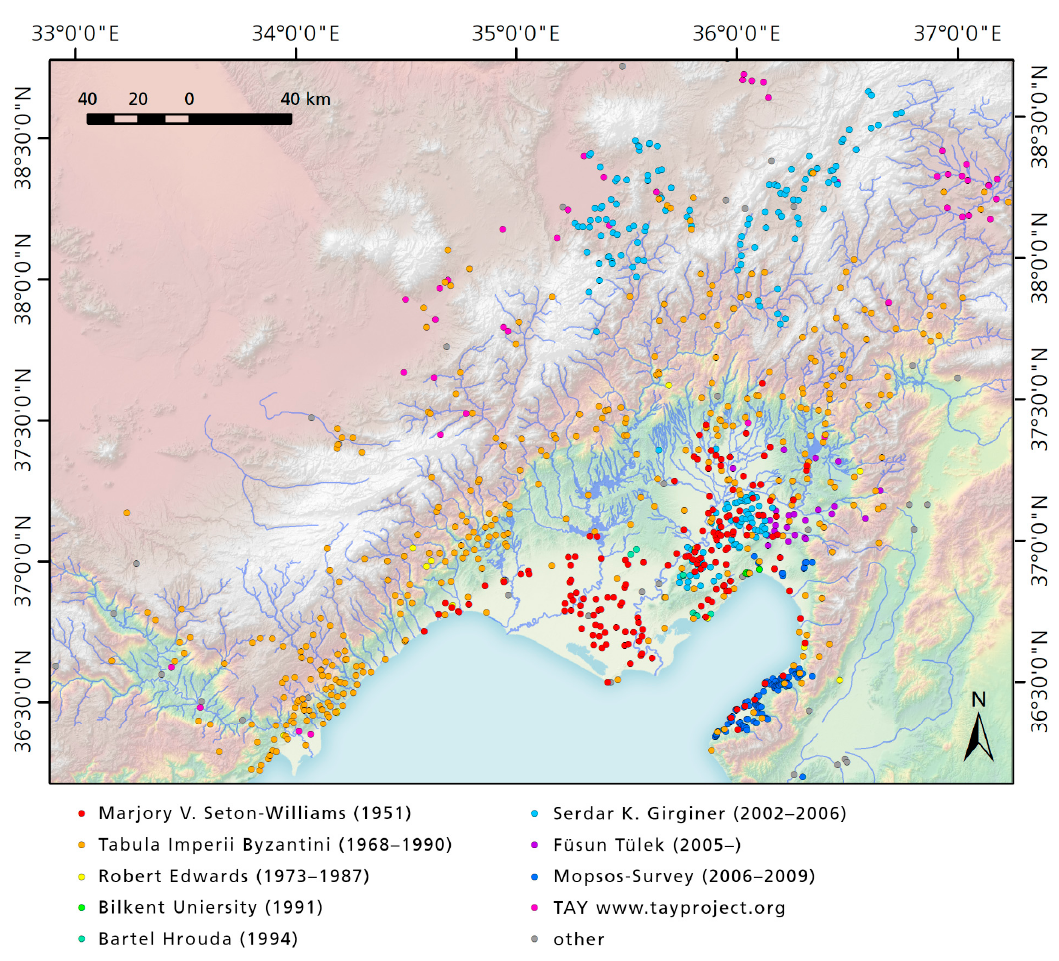
Figure 4. Distribution of archaeological sites investigated during different surveys in the Cilician Plain © Susanne Rutishauser.